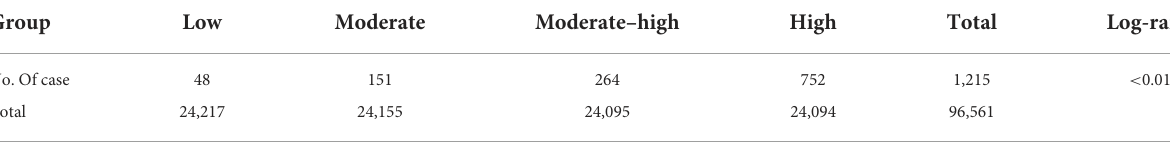
TABLE 2 Cumulative incidence of AF events in different ePWV